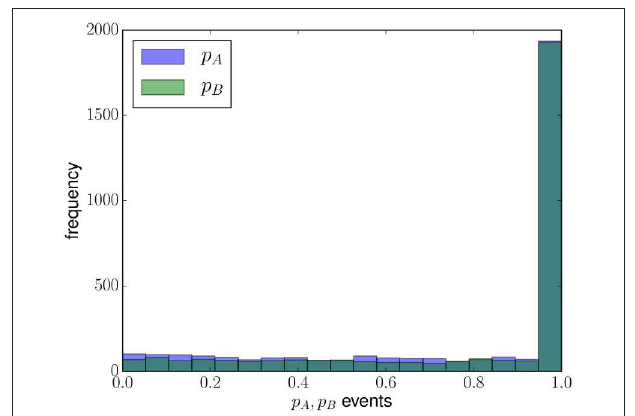
FIGURE 3 | Histograms of the Bayesian probabilities p A , p B computed by agents during their learning attempts during a single run (for N starting with SIC; n * ex , A 5, n * ex , B = =